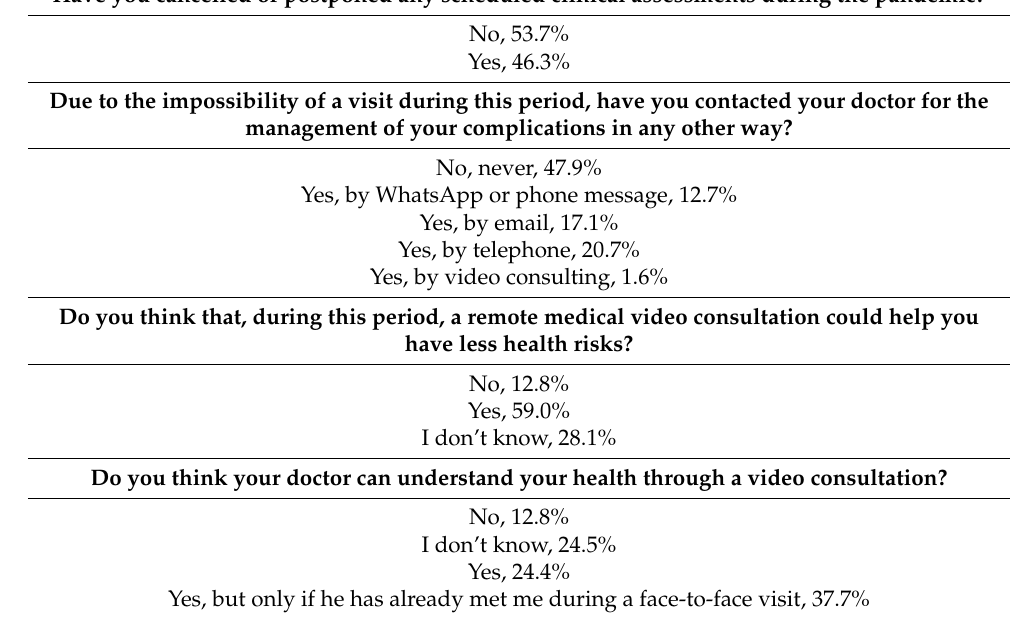
Table 2. Answers given by the participants to questions about medical care during the pandemic with relative percentage